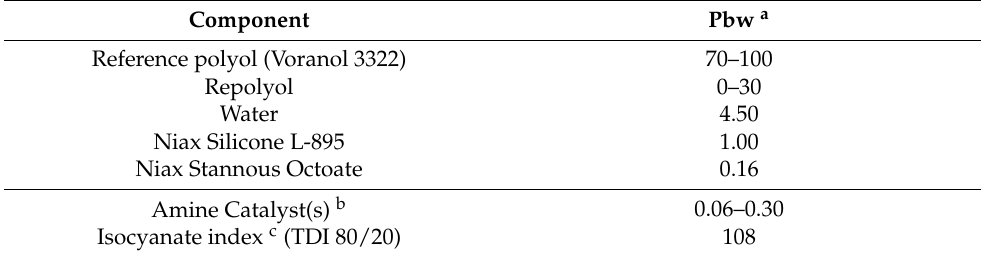
Table 1. Basic formulation of the flexible polyether foam.